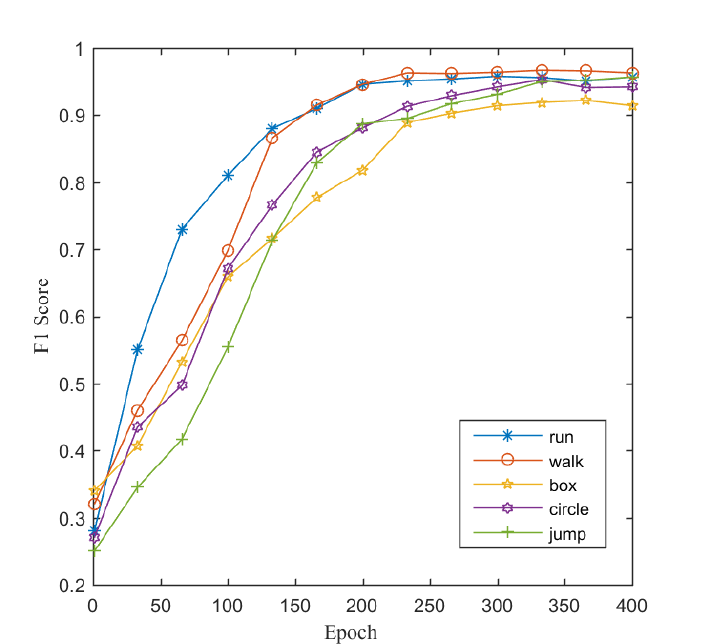
Figure 9. F1-score curves of five activities for person identification. “Run” has the highest F1-score, which indicates that the spectrogram of “run” is the most efficient for person identification among the five